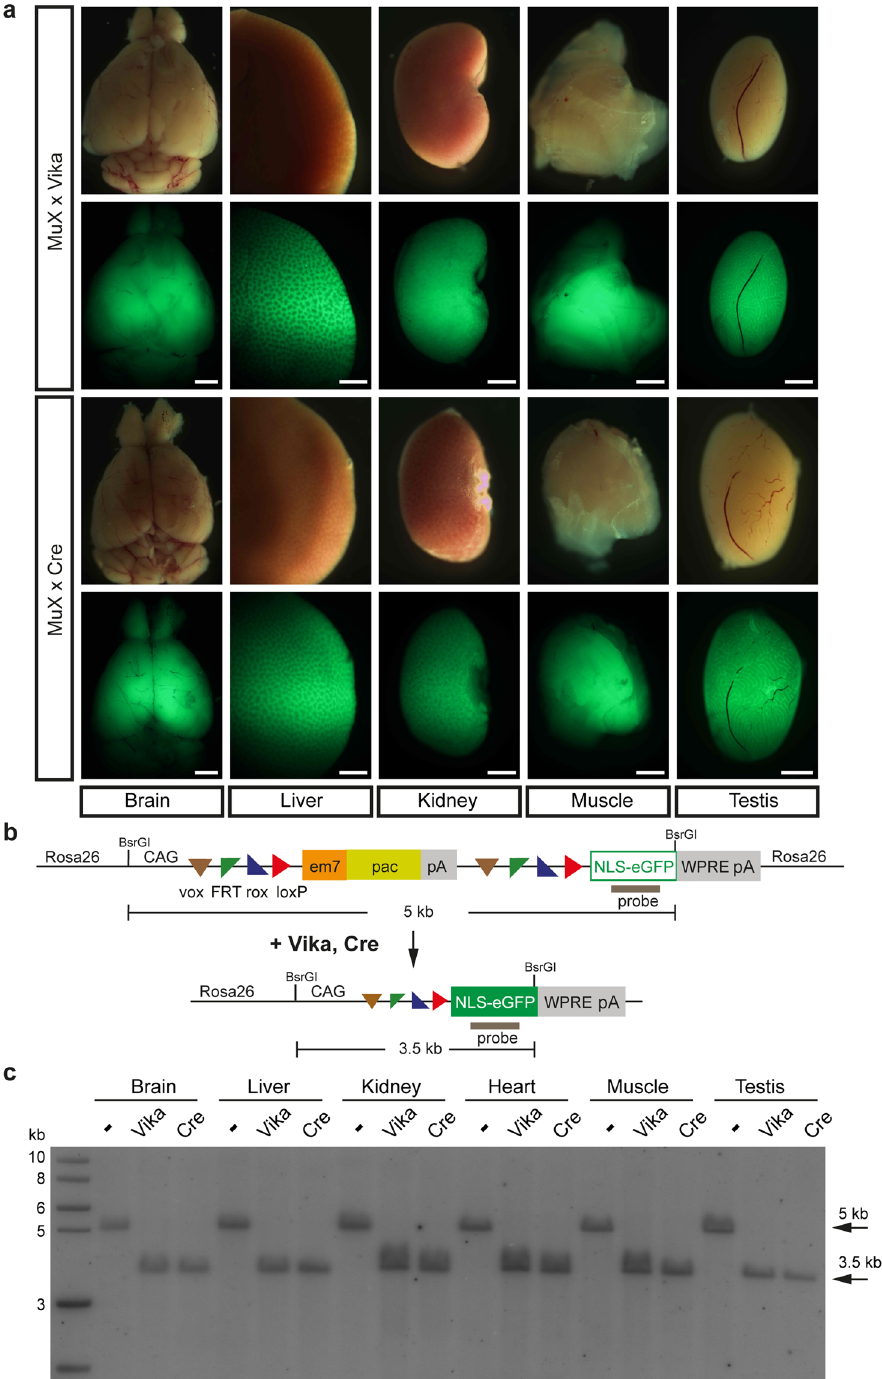
Figure 4. Vika-recombination is complete in adult tissues. ( a ) Organs isolated from MuX × Vika and MuX × Cre mice and analysed for GFP expression. Scale bar = 1 mm. ( b ) Schematic diagram of the Southern strategy for detecting recombination. ( c ) Southern blot showing complete recombination in all analysed